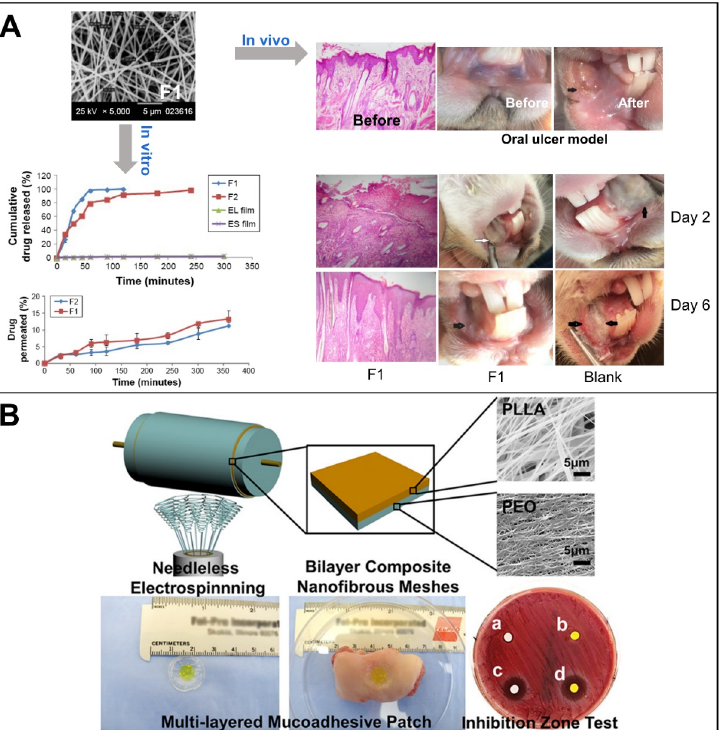
Figure 11. NSAIDs in the treatment of oral ulcers. ( A ) EL and ES nanofibers loaded with KET, reprint permission from ref. [29]. Copyright 2017, Dove Medical Press Ltd.; ( B ) CUR-PLLA